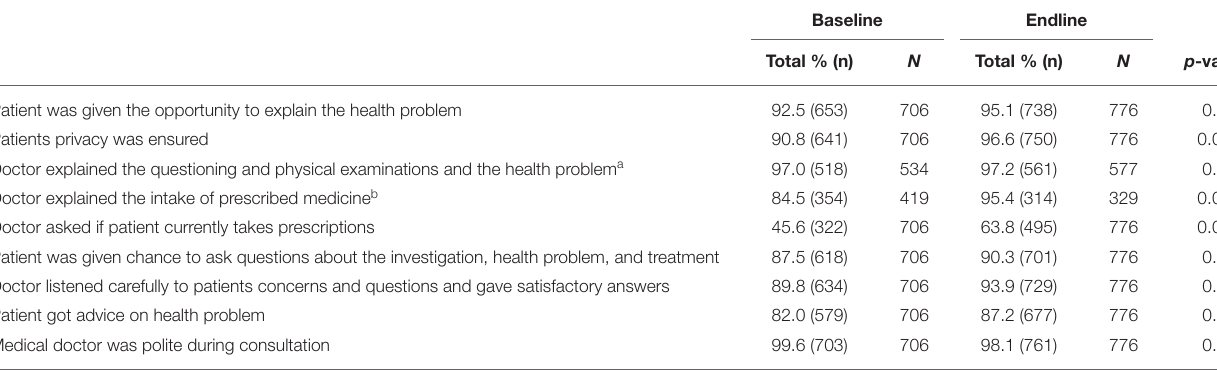
TABLE 5 | Satisfaction with different aspects of health service—exit